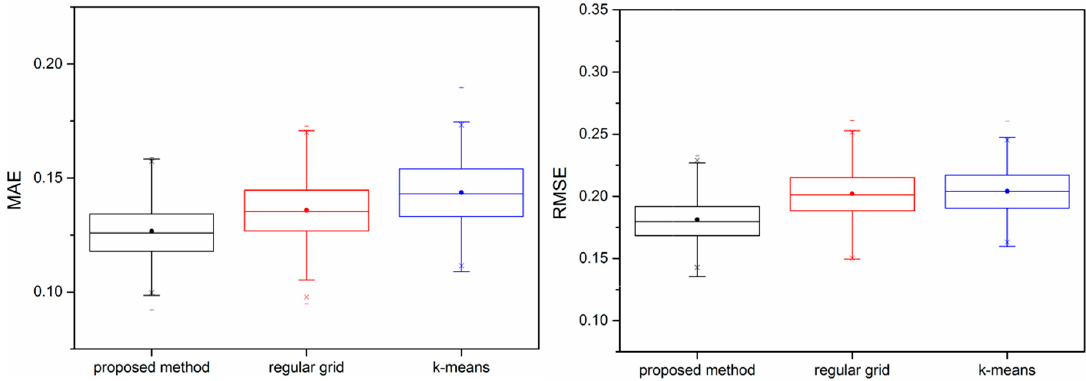
Figure 8. The MAE and RMSE results for the SOM content mapping using the three sampling design methods.